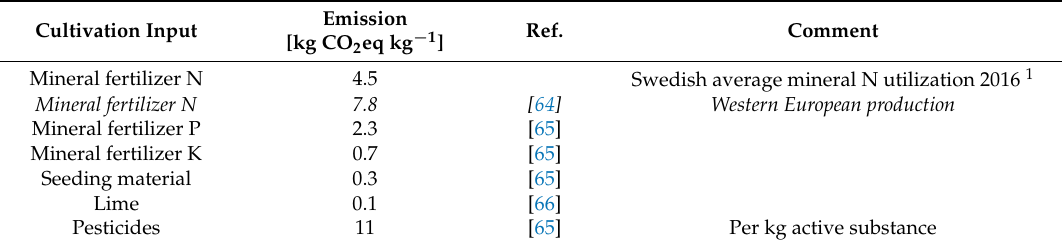
Table A16. Emissions from inputs in grain and straw cultivation. Values in italics are alternative values used in the sensitivity analysis. All other values were used in the base case.